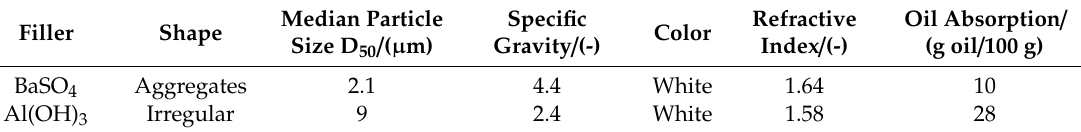
Table 3. Physical properties of fillers used in the